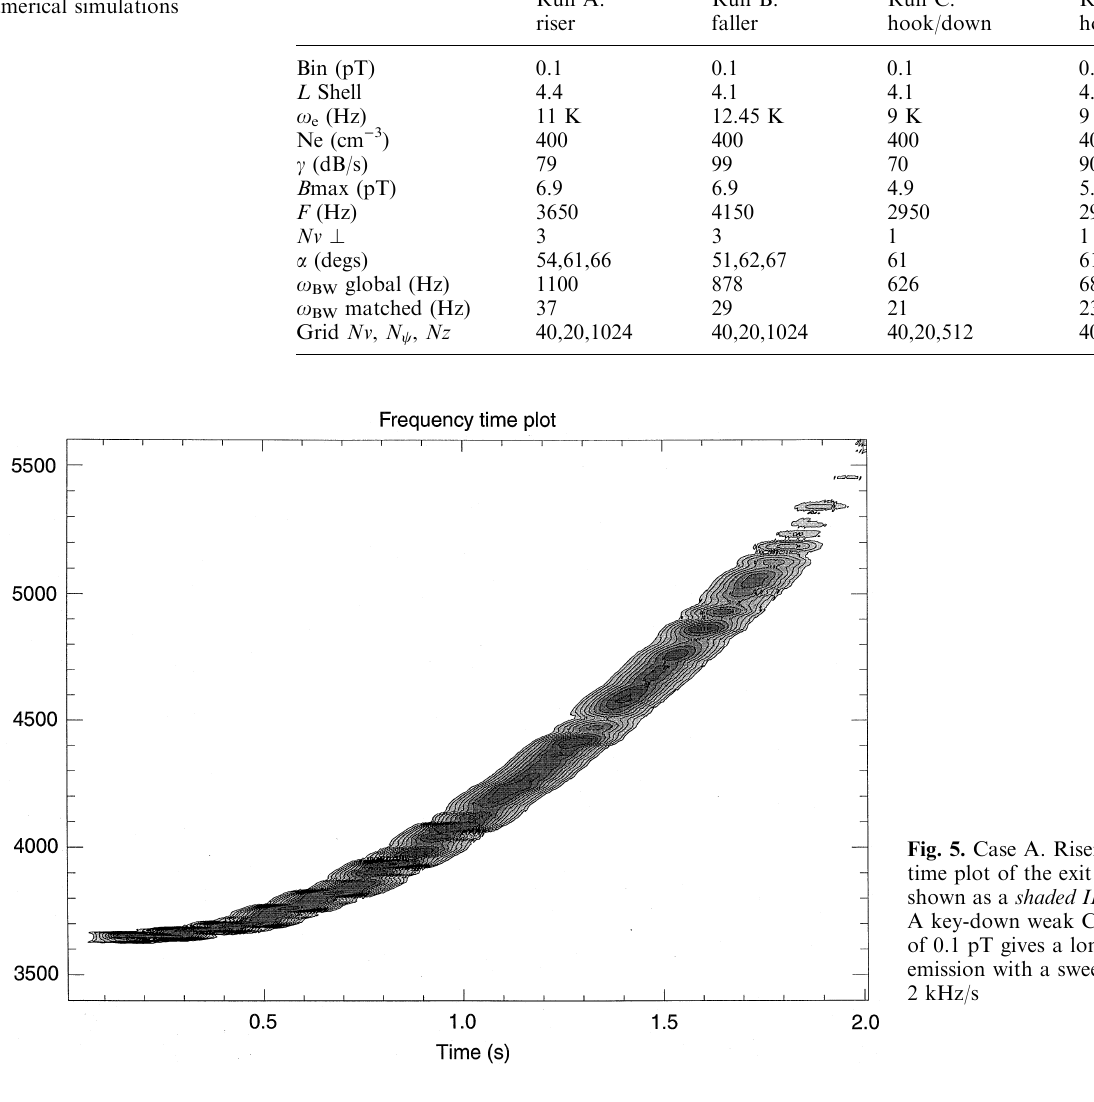
Table 1. Input data used for numerical simulations